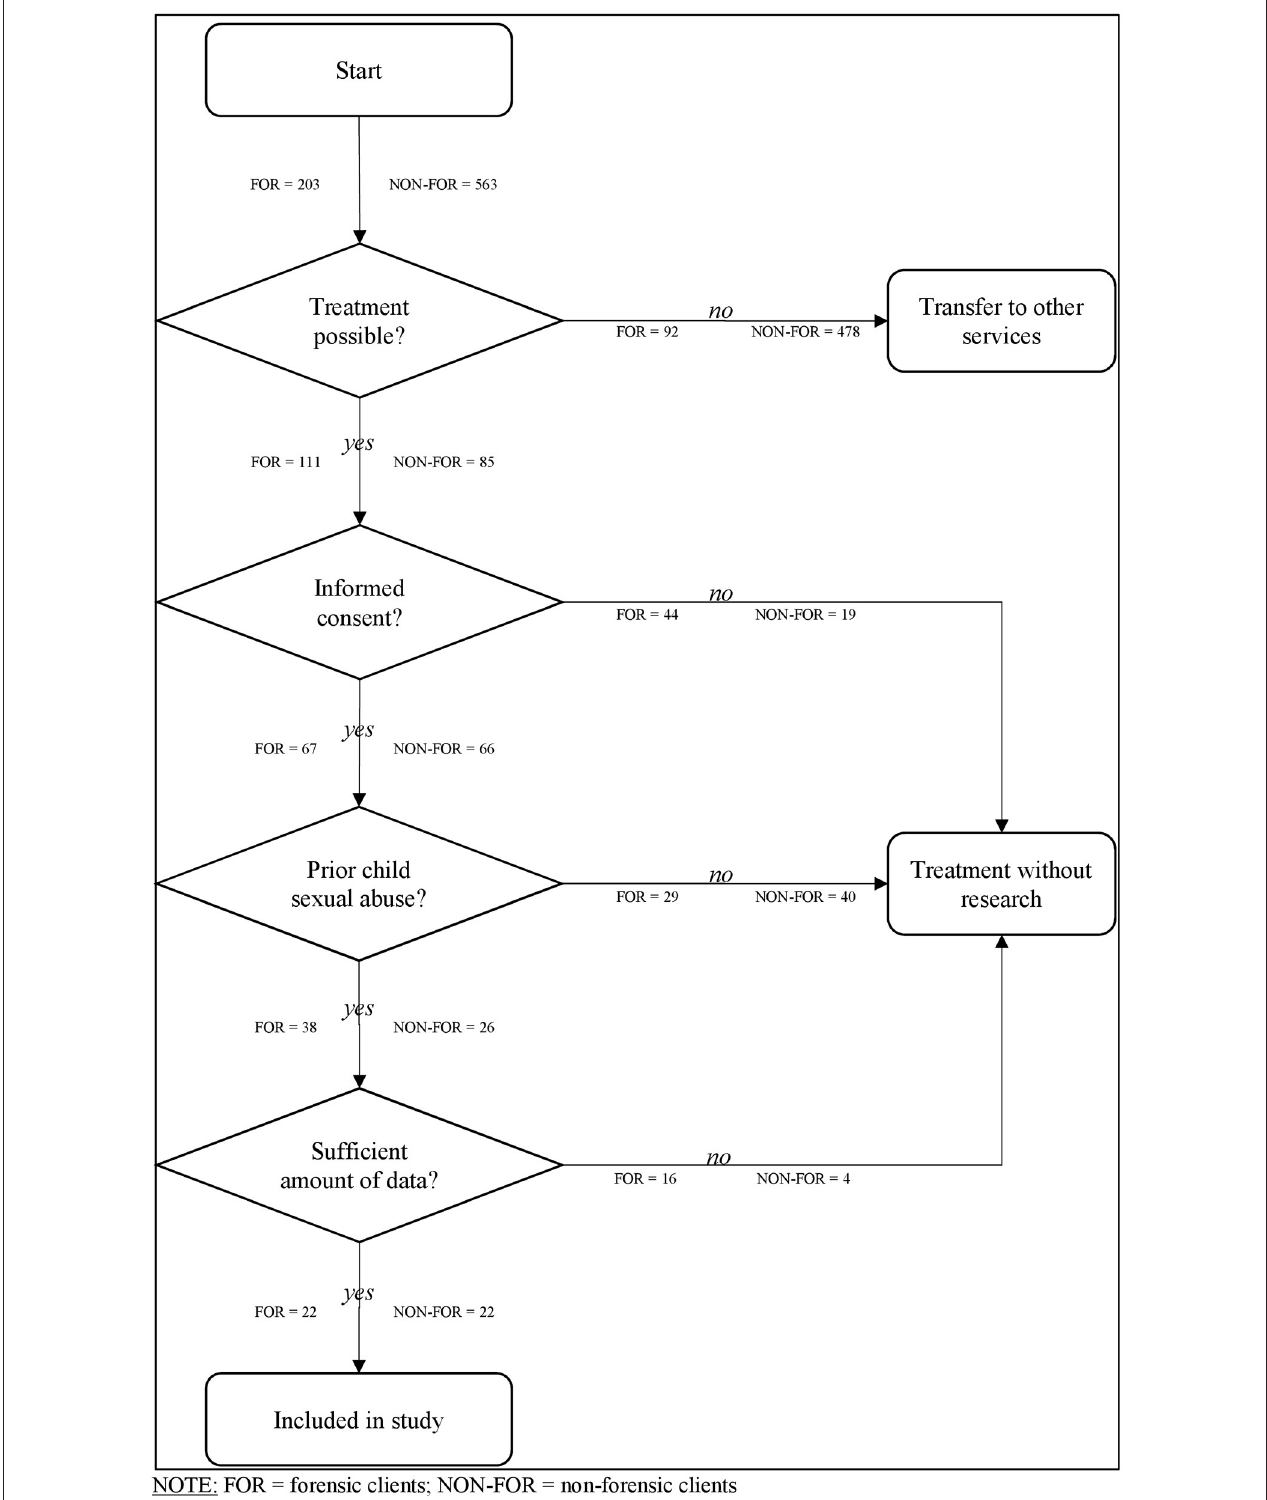
FIGURE 1 | Inclusion process of the study. FOR, forensic clients; NON-FOR, non-forensic clients.